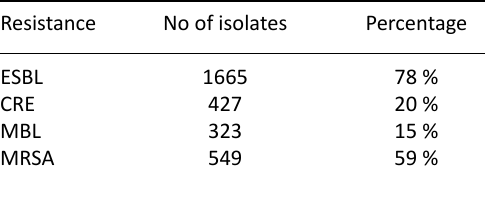
Table 3. Resistance pattern among bacterial isolates